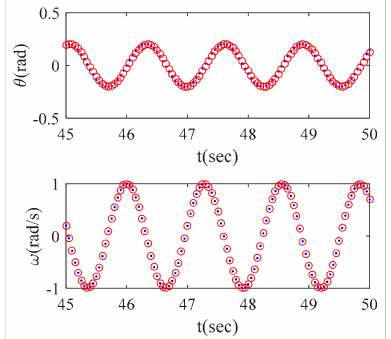
Figure 14. A comparison of two difference methods under the Lie group model with the time step of 0.05